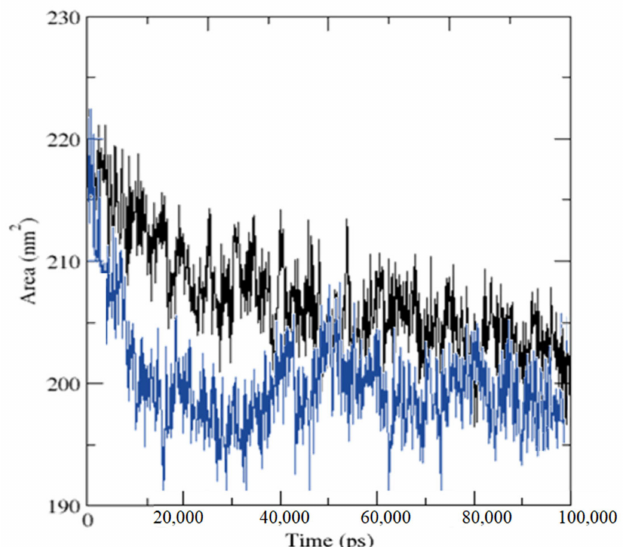
Figure 13. Number of average hydrogen bonding interactions between (left) HPLD complex and (right) CTtD complex during the 100 ns simulation time.